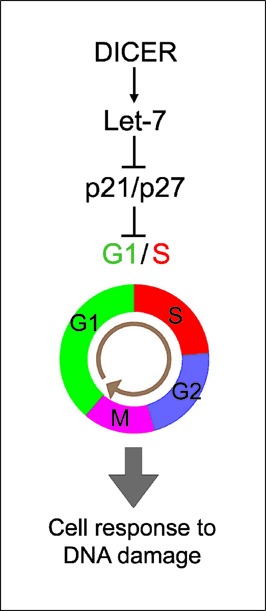
A model explaining how DICER modulates the cell's response to DNA damage through biogenesis of the let-7 family members that target p21/p27 to regulate the G1/S transition.